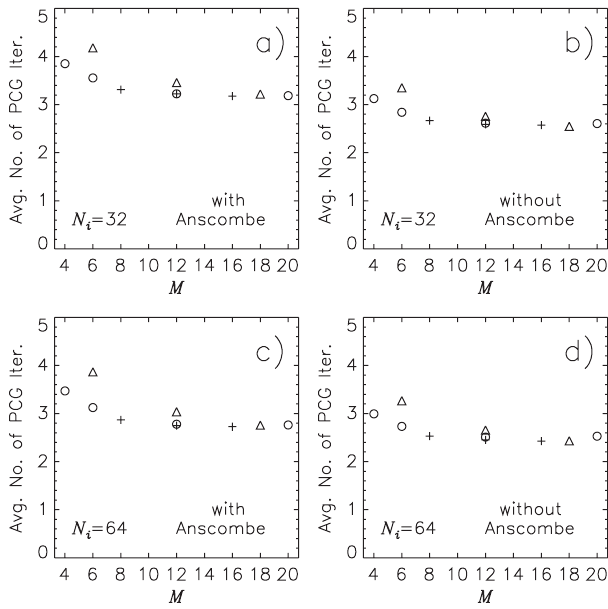
FIG. 18. Average number of iterations of IMPACT-T with PCG for a 30 000 -step full simulation of the Fermilab/NICADD (cid:4) photoinjector with Distribution 1 , and N (cid:4) 125 000 and N i 32 . The size of the compact support of the wavelet family ( M ) is given on the abscissa for Daubechies wavelets of order 2, 3, 6, and 10 (empty circles), symlets of order 4, 6, 8 (crosses), coiflets of order 1, 2, 3 (cid:4) 32 and N (cid:4) 64 grids (top two rows; left and right, N i i (cid:4) 4 : 58 and with 10 different respectively), the same N ppg wavelet families. The sparsity of the Laplacian operator in wavelet space is shown in the bottom row.